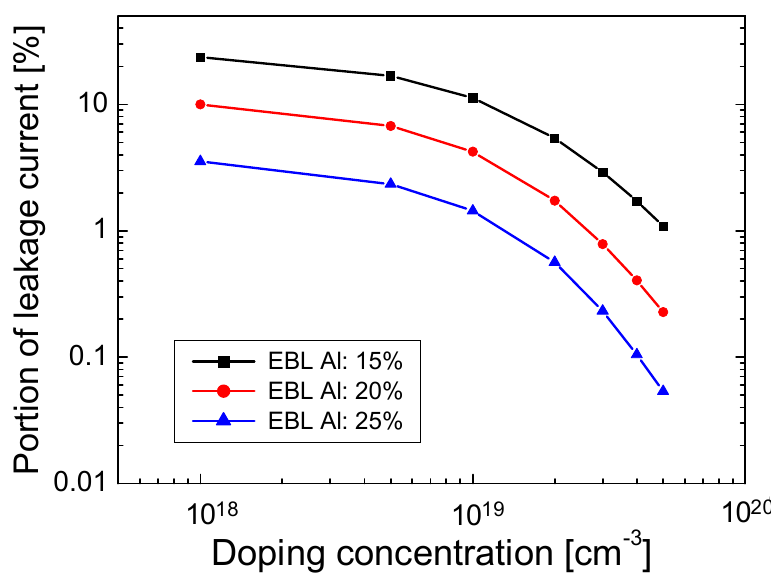
Figure 5. The portion of electron leakage current as a function of the Mg doping concentration in the AlGaN EBL for the Al compositions of 15%, 20%, and 25%.